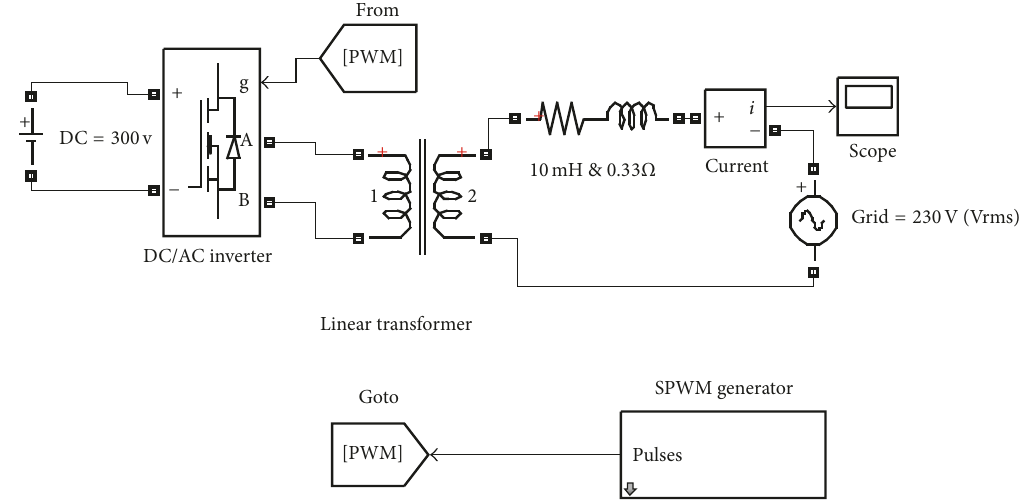
Figure 2: Open loop circuit diagram of the DC/AC grid connected inverter.